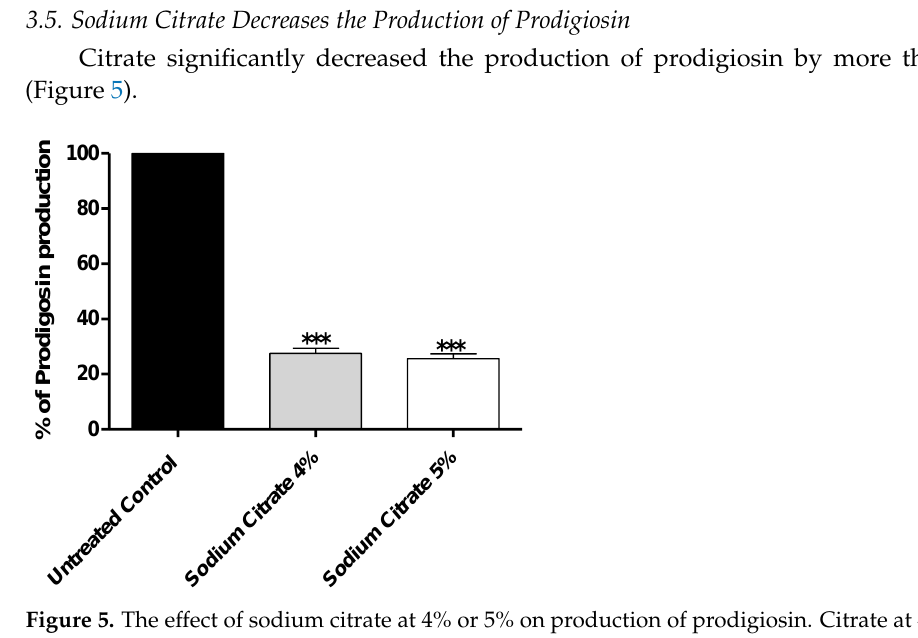
Figure 4. The effect of sodium citrate at 4% or 5% on the protease production. Citrate at 4% or 5% significantly decreased the clear zones around the wells loaded with extracellular protease (60%), indicating decrease in protease production. The One-way ANOVA test was employed to assess sig- nificance; ***: p ≤ 0.001.